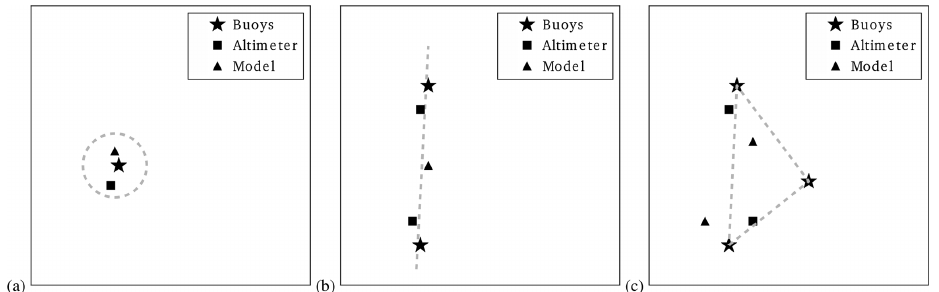
Figure 3. Illustration of three considered observation scenarios. (a) Data sources are assumed to provide information on the same quantity (0-D). (b) Measurements are located along a line and a 1-D linear approximation is employed for the measured quantity (1-D). (c) The same as (b) , but using a 2-D interpolation method for more general spatial distributions of data sources (2-D).